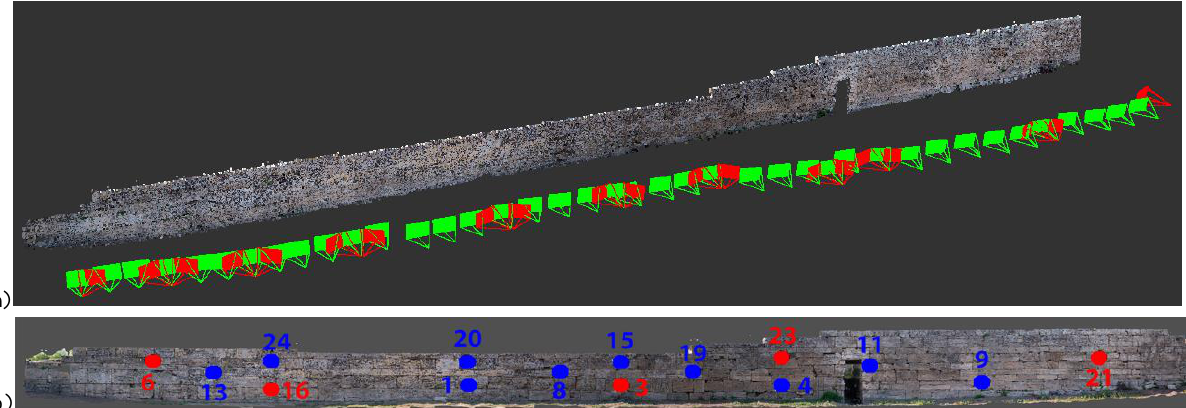
Figure 1: Camera network of the Paestum wall (a) with normal / vertical (green) and convergent / oblique (red) images. Orthophoto of the wall with the GCPs (red points) and CPs (blue points) distribution